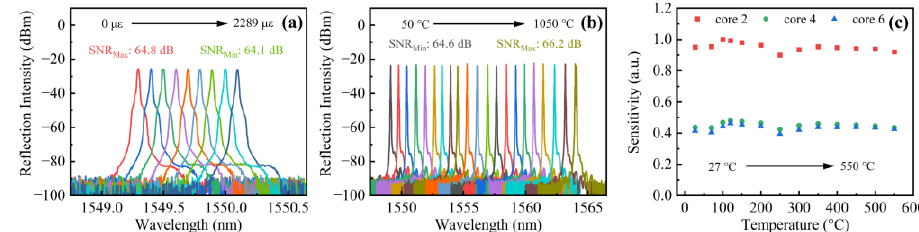
Figure 7. Evolution of reflection spectra of the accelerometer at ( a ) various strains ranging from 0 to 2289 με and ( b ) various temperatures ranging from 50 to 1050 °C. ( c ) Sensitivity-temperature responses of the accelerometer in the range of 27 to 550 °C with an exciting frequency of 40 Hz and an acceleration of 5.0 g.